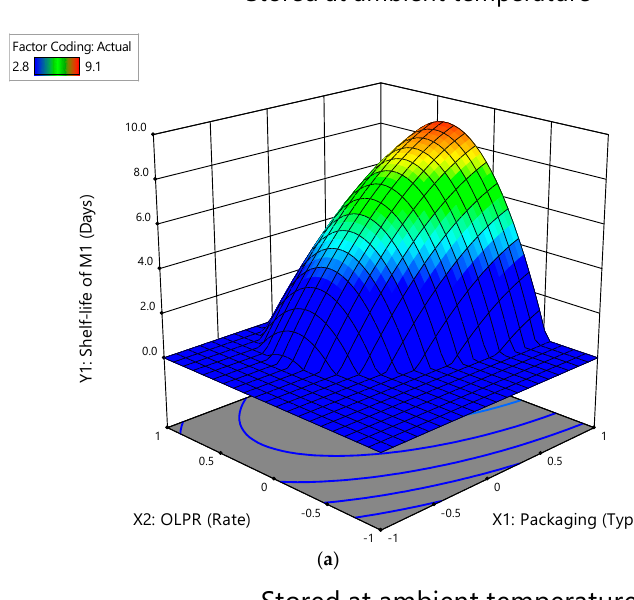
10 of 28 Figure 2. Measured vs. predicted bi-plots for shelf-life extension of mushrooms stored at ambient temperature: ( a ) M 1 (mushrooms of WS and OLPR mixtures), ( b ) M 2 (mushrooms of WS and SCG mixtures), and ( c ) M 3 (mushrooms of WS and OLPR/SCG mixtures).